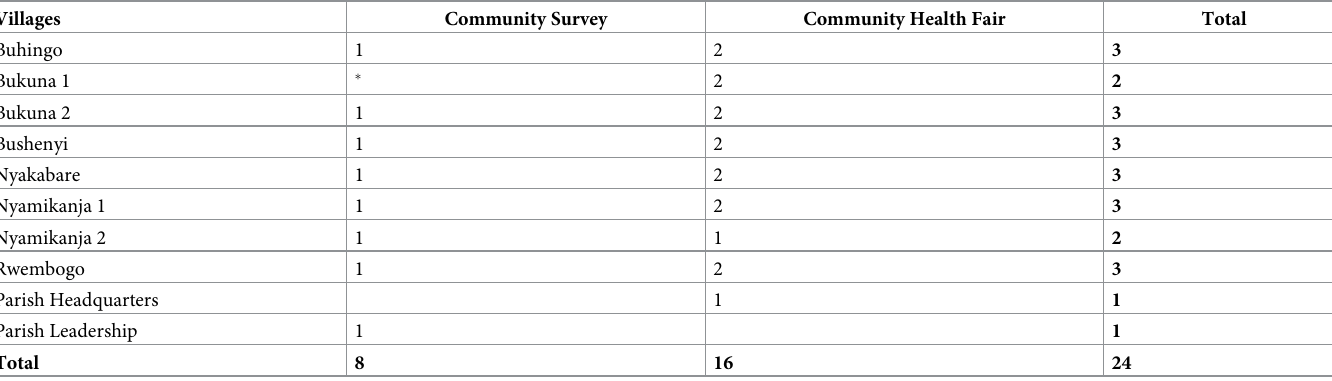
Table 1. Sensitization meetings before each study